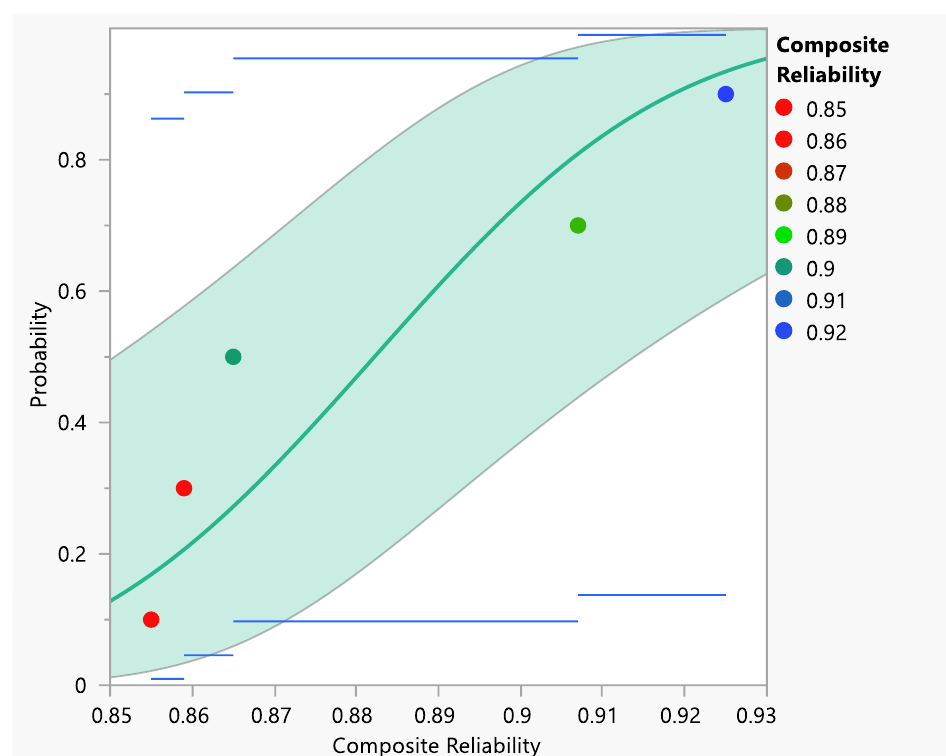
Figure 6. Normal probability curve of composite reliability.